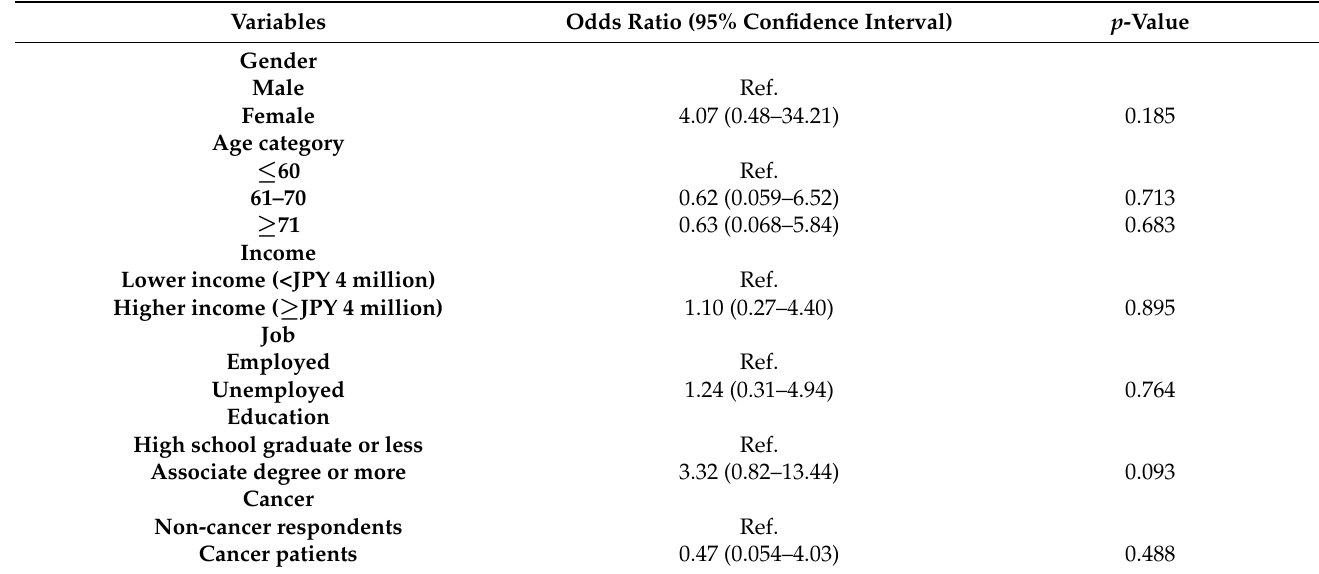
Table 5. Logistic regression analysis of the influence of physician–Pharma relationships on respon- dents’